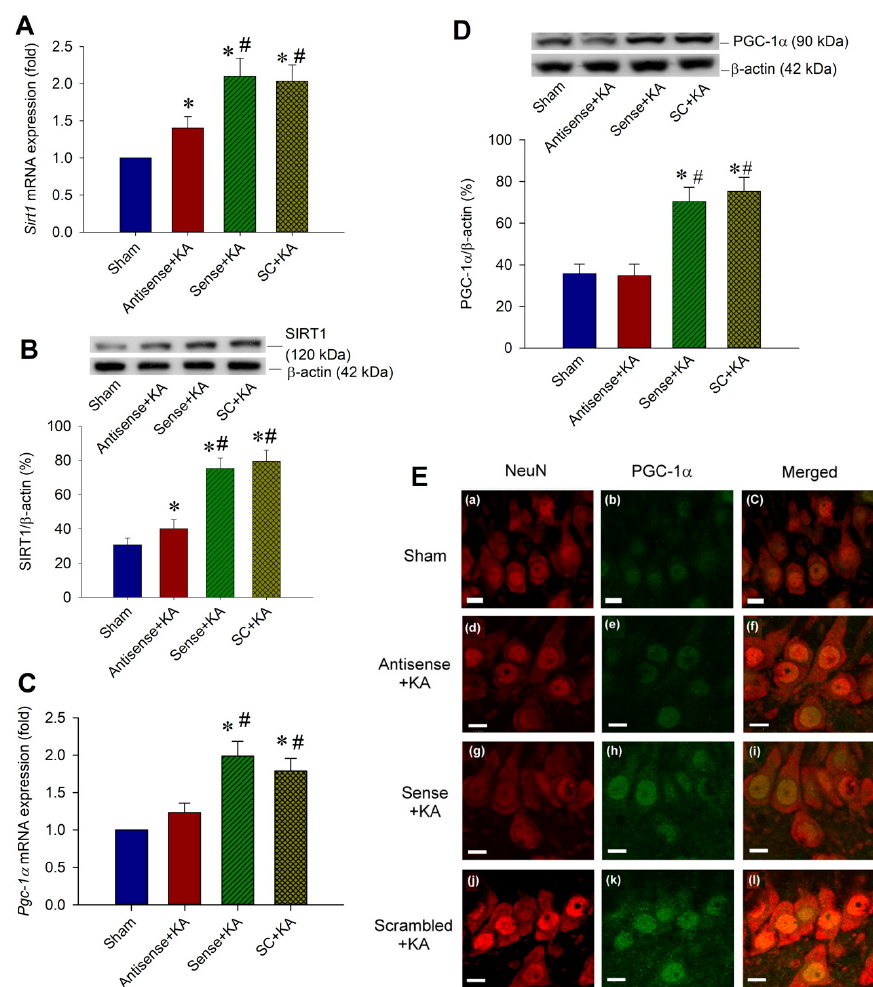
Figure 3. Blockade of PGC-1 α expression by antisense oligodeoxynucleotides (ODNs) against Sirt1 . Rats were microinjected into bilateral CA1 subfields with sense ODN, antisense ODN, or scrambled (SC) ODN for Sirt1, 1 nmol each, 24 h before the microinjection of KA into the left hippocampal CA3. ( A ) Changes of Sirt1 mRNA expression from the CA3 subfield of the hippocampus 3 h after the microinjection of KA (0.5 nmol) into the left hippocampal CA3 subfield, and received 24 h before pre-treatment with application into the bilateral CA3 subfield of sense, antisense, or SC ODNs for Sirt1 (1 nmol). ( B ) Representative gels (inset) or changes in SIRT1 relative to β -actin from the CA3 subfield of the hippocampus 3 h after the same experiments. ( C ) Changes of Sirt1 mRNA expression from the CA3 subfield of the hippocampus 6 h after the microinjection of KA (0.5 nmoL) into the left hippocampal CA3 subfield, and received 24 h before pre-treatment with application into the bilateral CA3 subfield of sense, antisense, or SC ODNs for Sirt1 (1 nmol). ( D ) With the same experimental conditions in ( C ), Western blot showed the changes of PGC-1 α expression relative to β -actin (42 kDa), 6 h after the microinjection of KA (0.5 nmol) and various ODN against Sirt1 (1 nmoL). Values are the mean ± SEM of quadruplicate analyses from six animals per experimental group. * p < 0.05 versus the sham control group, # p < 0.05 versus the Sirt1 antisense ODN + KA group in the Sche ff é multiple-range test. ( E ) Laser scanning confocal microscopic images of a representative cell in the right CA3b subfield of the hippocampus that was immunoreactive to a neuronal marker, NeuN (red fluorescence) and additionally stained for PGC-1 α (green fluorescence) in the sham-control animals ( E-a,b,c ), or 6 h after the microinjection of KA (0.5 nmol) into the left hippocampal CA3 subfield in animals that received pre-treatment with application into the bilateral CA3 subfield 24 h after animals received antisense ( E-d,e,f ), sense ( E-g,h,i ), or SC ( E-j,k,l ) ODN against Sirt1 (1 nmoL). Scale bar, 10 µ